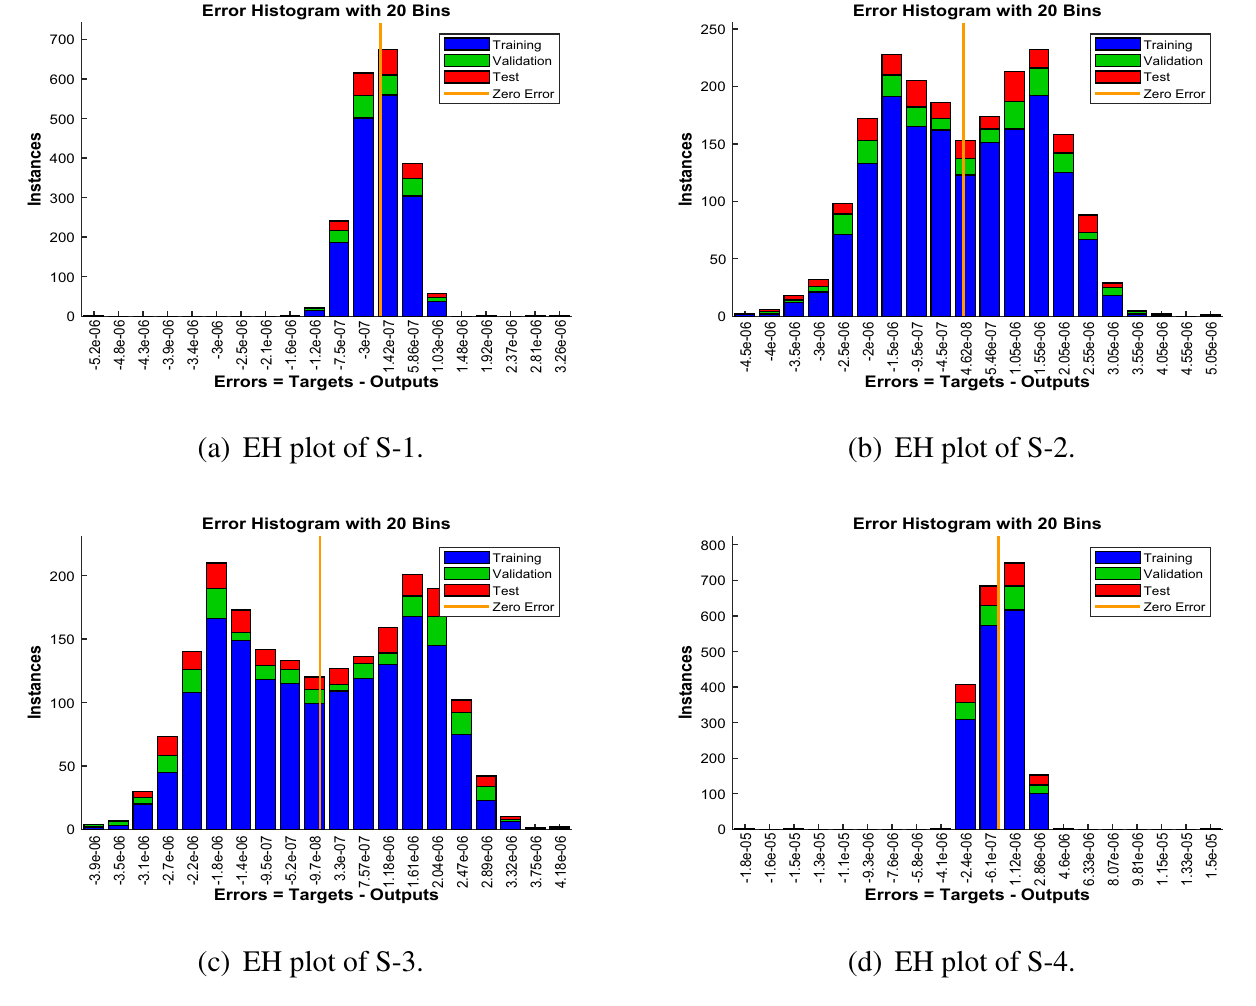
(a) EH plot of S-1. (b) EH plot of S-2.